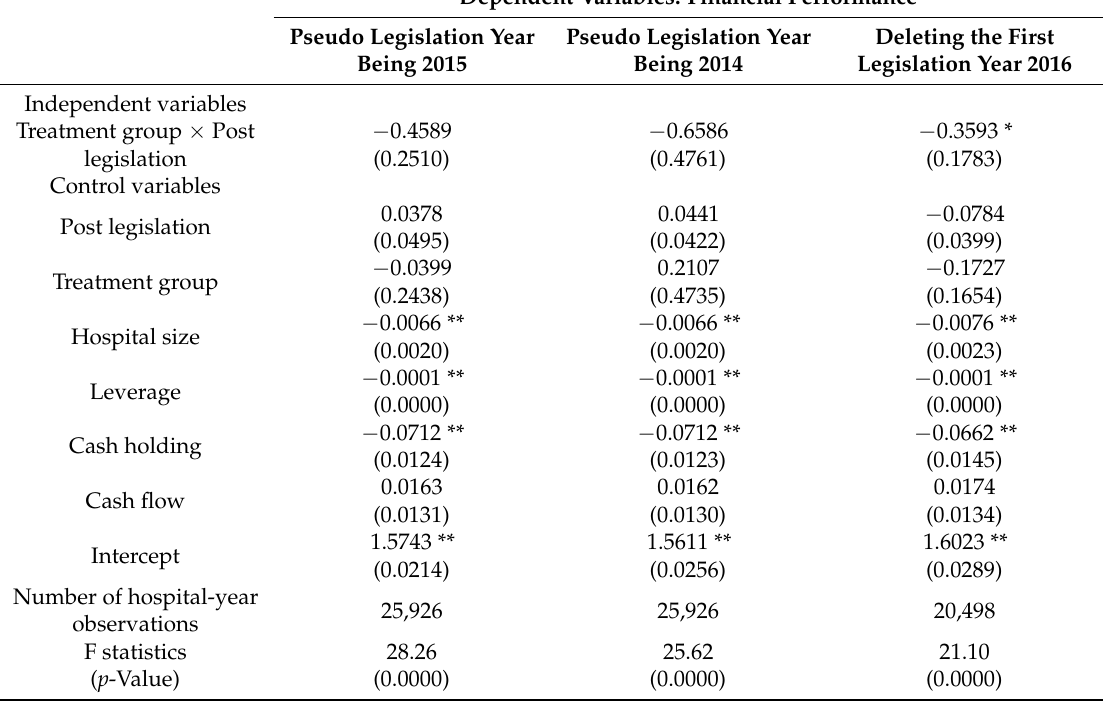
Table 2. Placebo